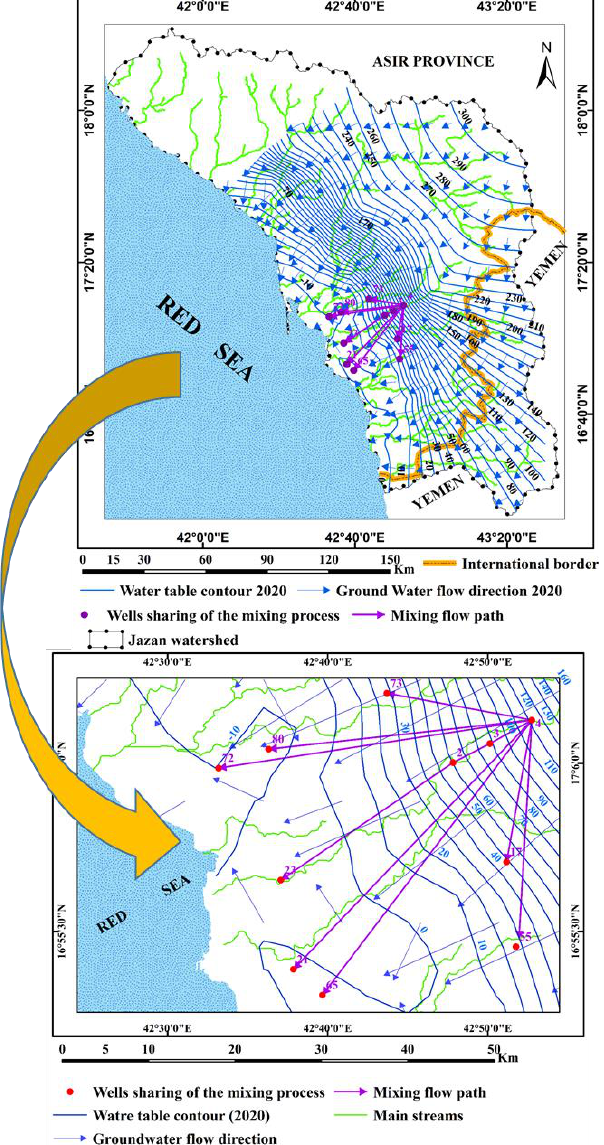
Figure 7. Mixing ratios of three reference waters known as initial waters or (4, rain, and sea) in samples (17, 21, 55, 65, 72, 7,3, and 80) as final waters.